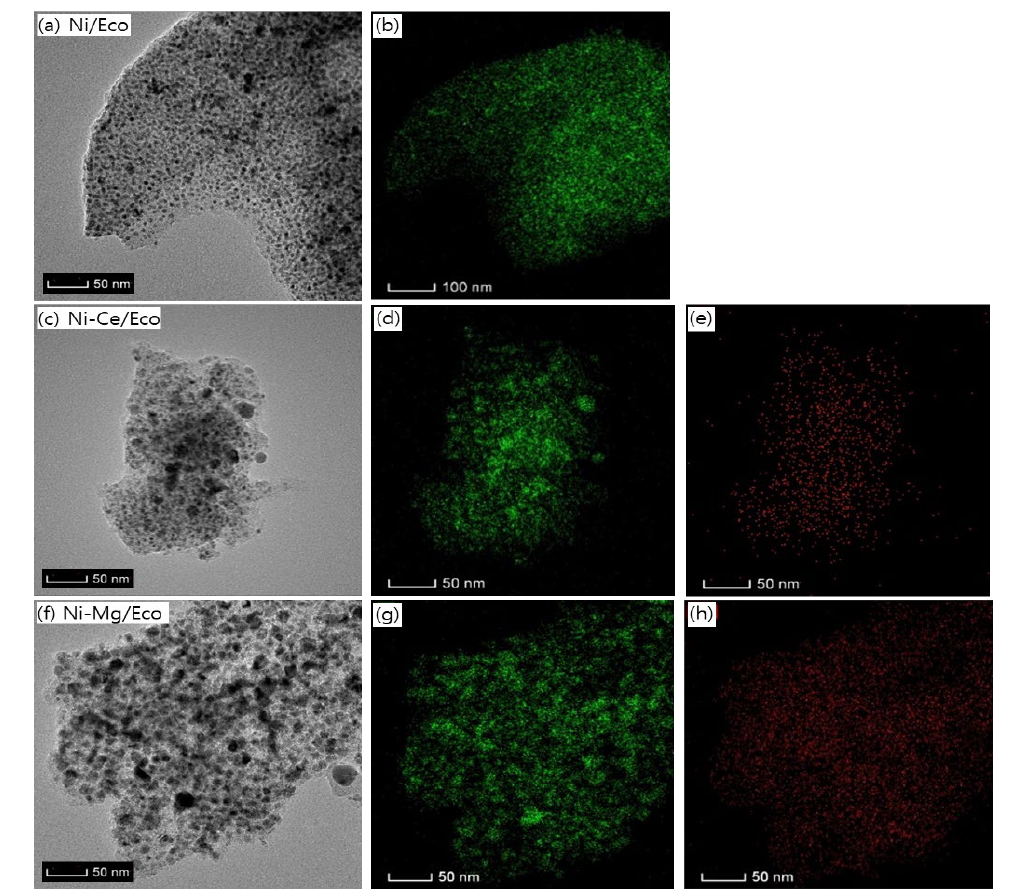
Figure 7. TEM images and metal mappings ( a ) Ni/Eco, ( b ) Ni dispersion at Ni/Eco, ( c ) Ni-Ce/Eco, ( d ) Ni dispersion at Ni-Ce/Eco, ( e ) Ce dispersion at Ni-Ce/Eco, ( f ) Ni-Mg/Eco, ( g ) Ni dispersion at Ni-Mg/Eco, and ( h ) Mg dispersion at